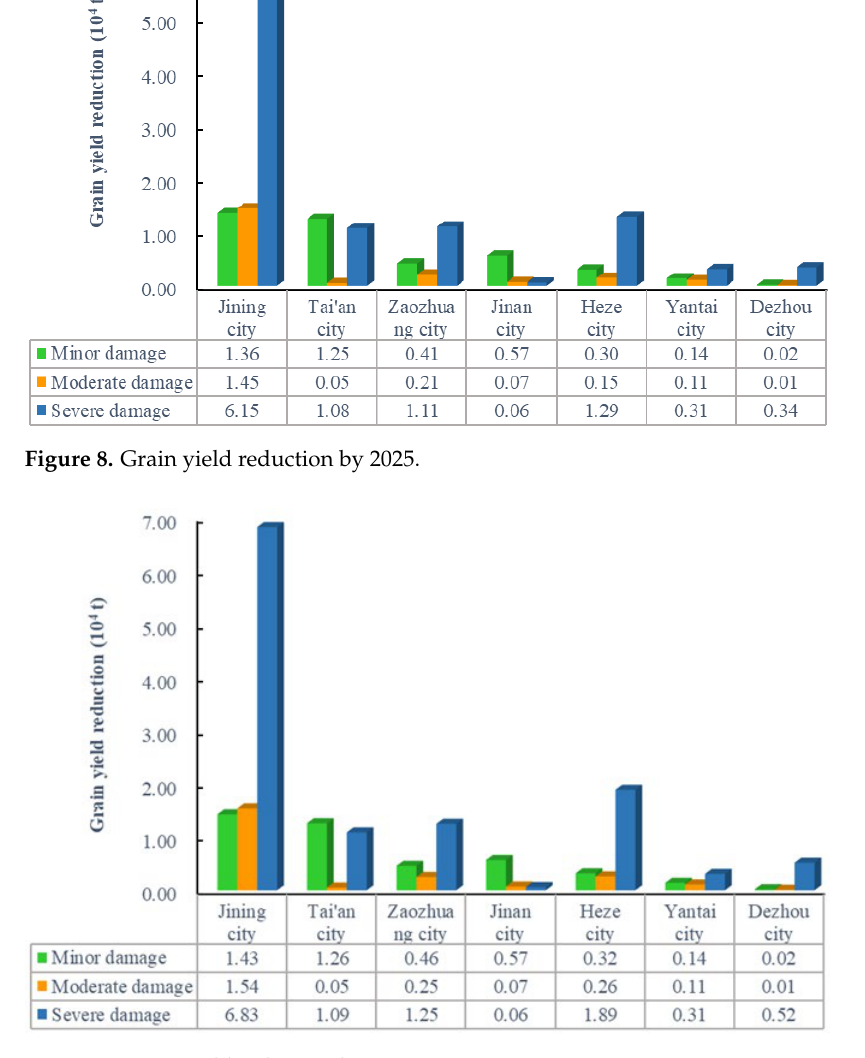
Figure 10. Mechanism of farmland damage in COA. ( a ) Crops grow normally before coal mining. ( b ) Damaged cropland with altered landscape patterns after coal mining. 3.4.3. Damage to Ecological Environment As shown in Figure 11, during the coal mining process, it is easy to destroy the land structure of the mining area and its surrounding areas. The collapse of coal mining causes slopes in formerly flat farmland, disturbing the originally relatively stable soil structure and geological environment [45–48]. Slight neglect of coal mining may adversely affect